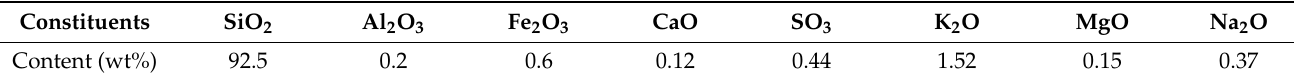
Table 3. Chemical composition of